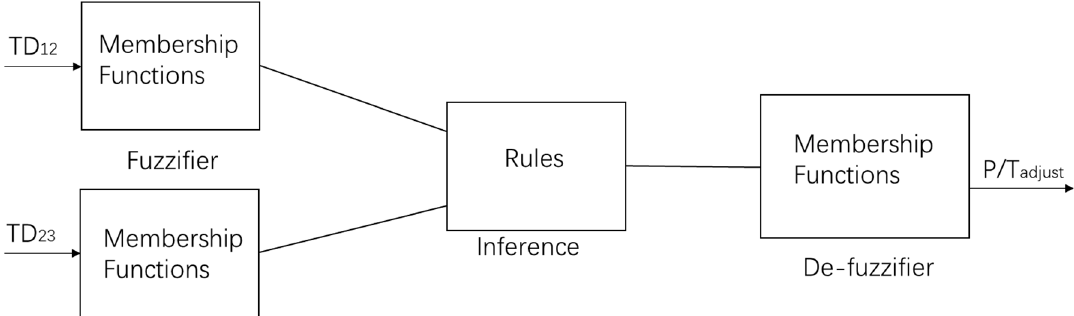
Figure 5. Data structure of Fuzzy Logic System for P/T adjust.